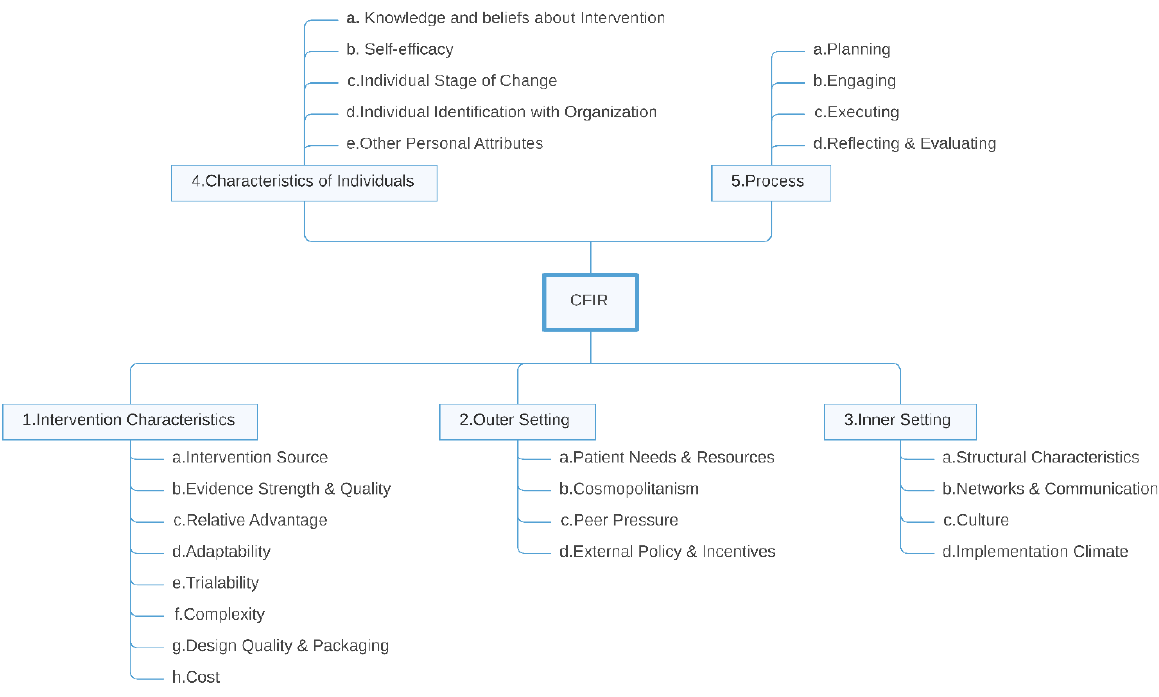
Figure 1. Theoretical constructs of the Consolidated Framework for Implementation Research (CFIR).